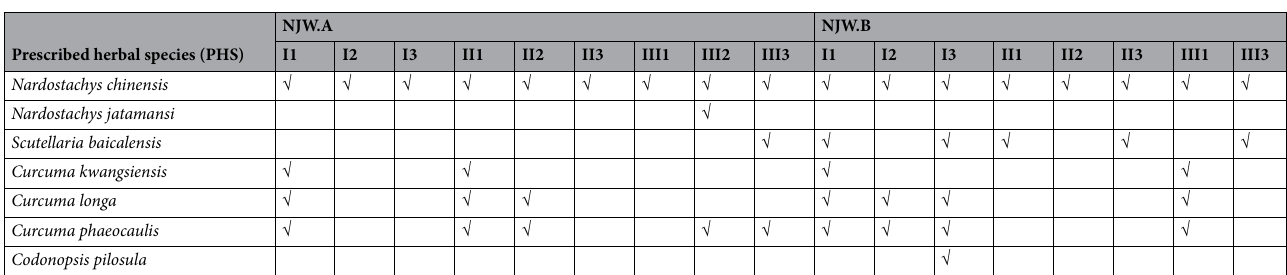
Table 5. Prescribed herbal species for NJW preparation and their presence in each sample by the multi- barcode sequencing approach based on trnL biomarker.